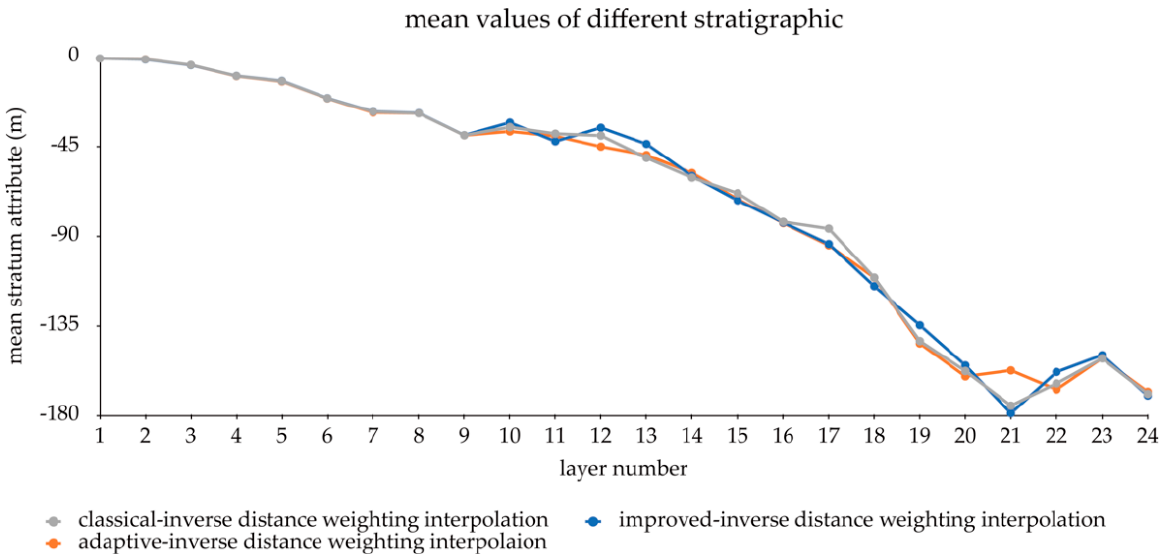
Figure 13. Mean values of different stratigraphic properties. The above analysis indicates that the data-adaptive inverse-distance weighting inter- polation method proposed in this paper based on the first-order neighborhood selection strategy takes into account the spatial difference of geological attributes and can effectively improve the interpolation efficiency of large-scale geological modeling. In this case, com- pared with the existing improved inverse-distance interpolation algorithm, the